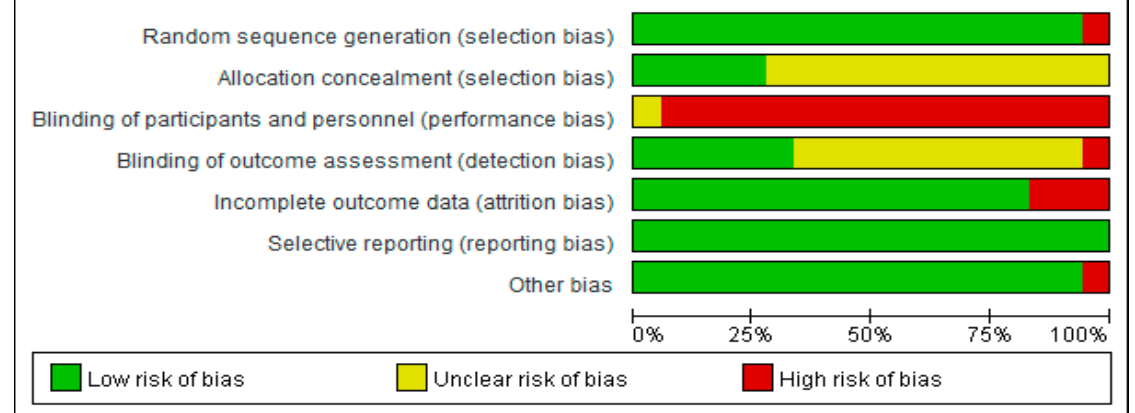
Figure 2. Assessment of risk of bias in included studies.